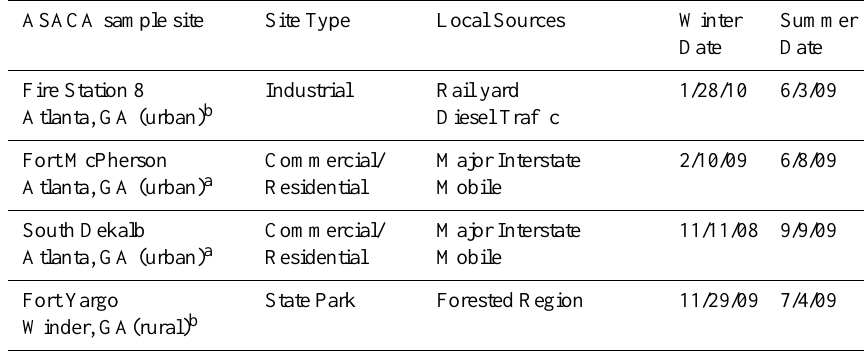
Table 1. ASACA filter